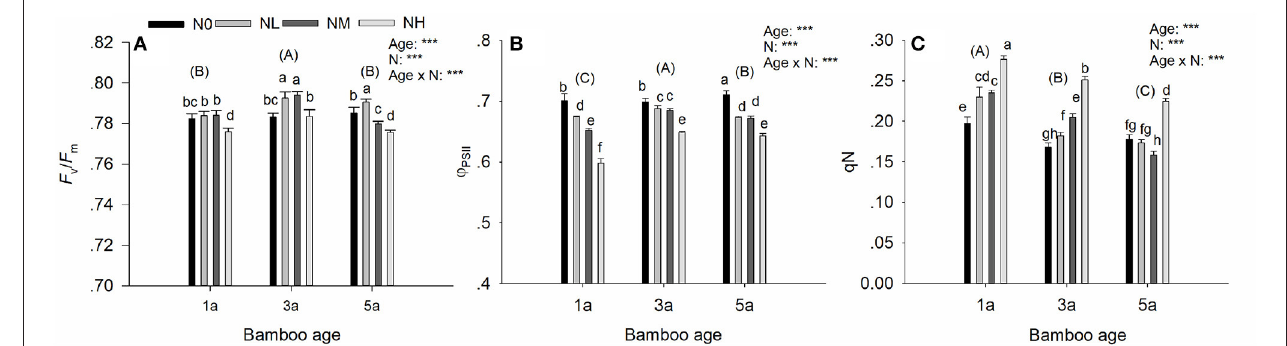
FIGURE 3 | Effects of nitrogen deposition and tree age on fluorescence parameters in Moso bamboo leaves in a factorial experiment. One-year-old (1a), 3-year-old (3a), and 5-year-old (5a) trees were included in the experiment. Nitrogen deposition treatments: Ambient deposition with no addition (N0, control), low addition (NL = 30kg N ha − 1 year − 1 ), medium addition (NM = 60kg N ha − 1 year − 1 ), and high addition (NH = 90kg N ha − 1 year − 1 ). Each treatment had three replicates ( n = 3). (A) maximal quantum yield of photosystem II ( F v / F m ), (B) PSII operating efficiency ( 8 PSII ), and (C) non-photochemical quenching (qN). For each parameter mean ± SE is indicated. Bars with different lower-case letters indicate significant differences between all combinations of treatment and age, whereas groups of bars with different upper-case letters in parentheses indicate significant differences between the tree age classes ( α = 0.05 in post-hoc one-way ANOVA combined with pair-wise Tukey’s tests). A summary of the results of a two-way ANOVA addressing the effects of nitrogen deposition and tree age is seen in the upper right-hand corner of each panel (*** P < 0.001; ns, non-significant).